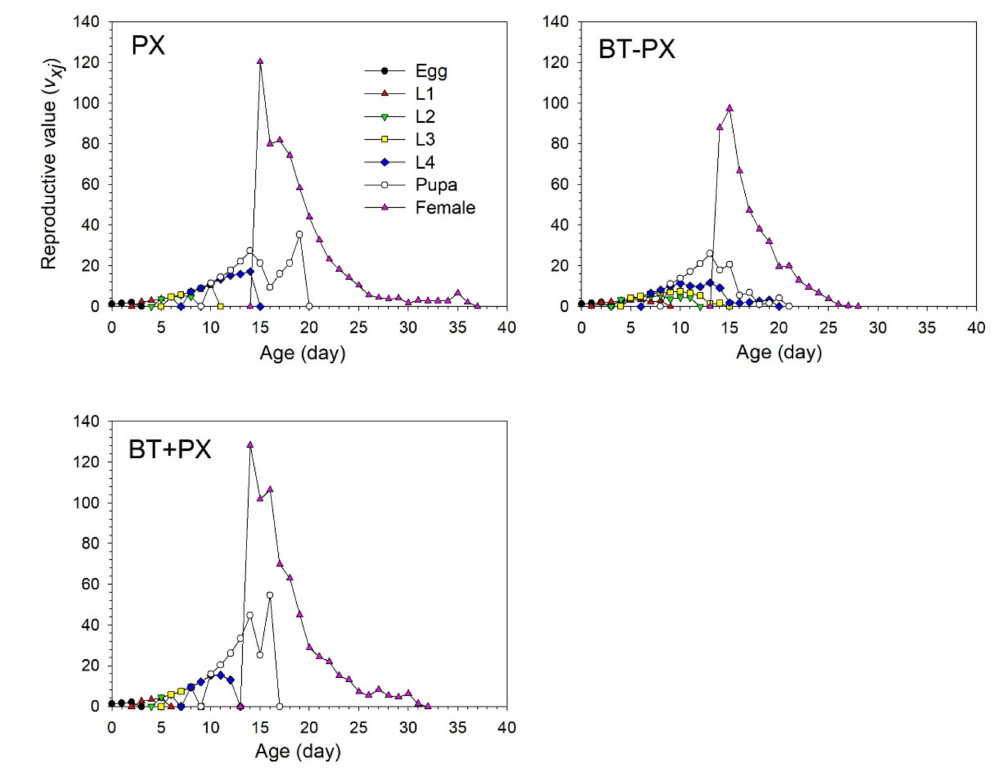
Figure 7. Age-stage specific reproductive value ( v xj ) of Plutella xylostella when feeding on Chinese kale alone (PX), with prior Bemisia tabaci damage (BT − PX) or with simultaneous B. tabaci damage (BT +